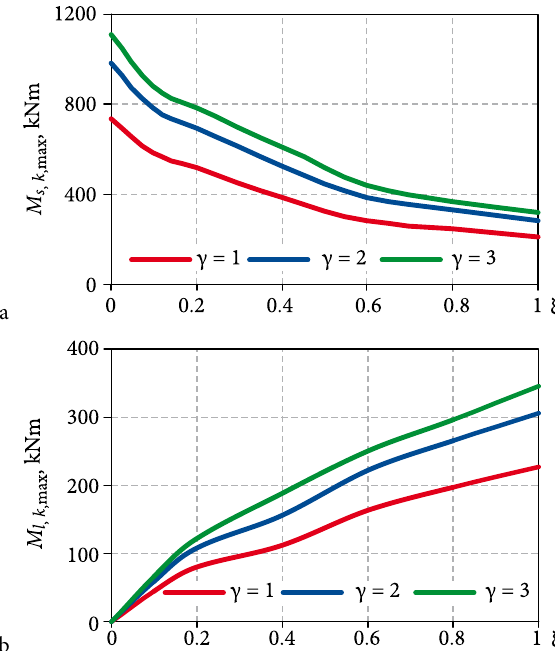
Fig. 8. Max moments at the quarter point in the stiffening girder